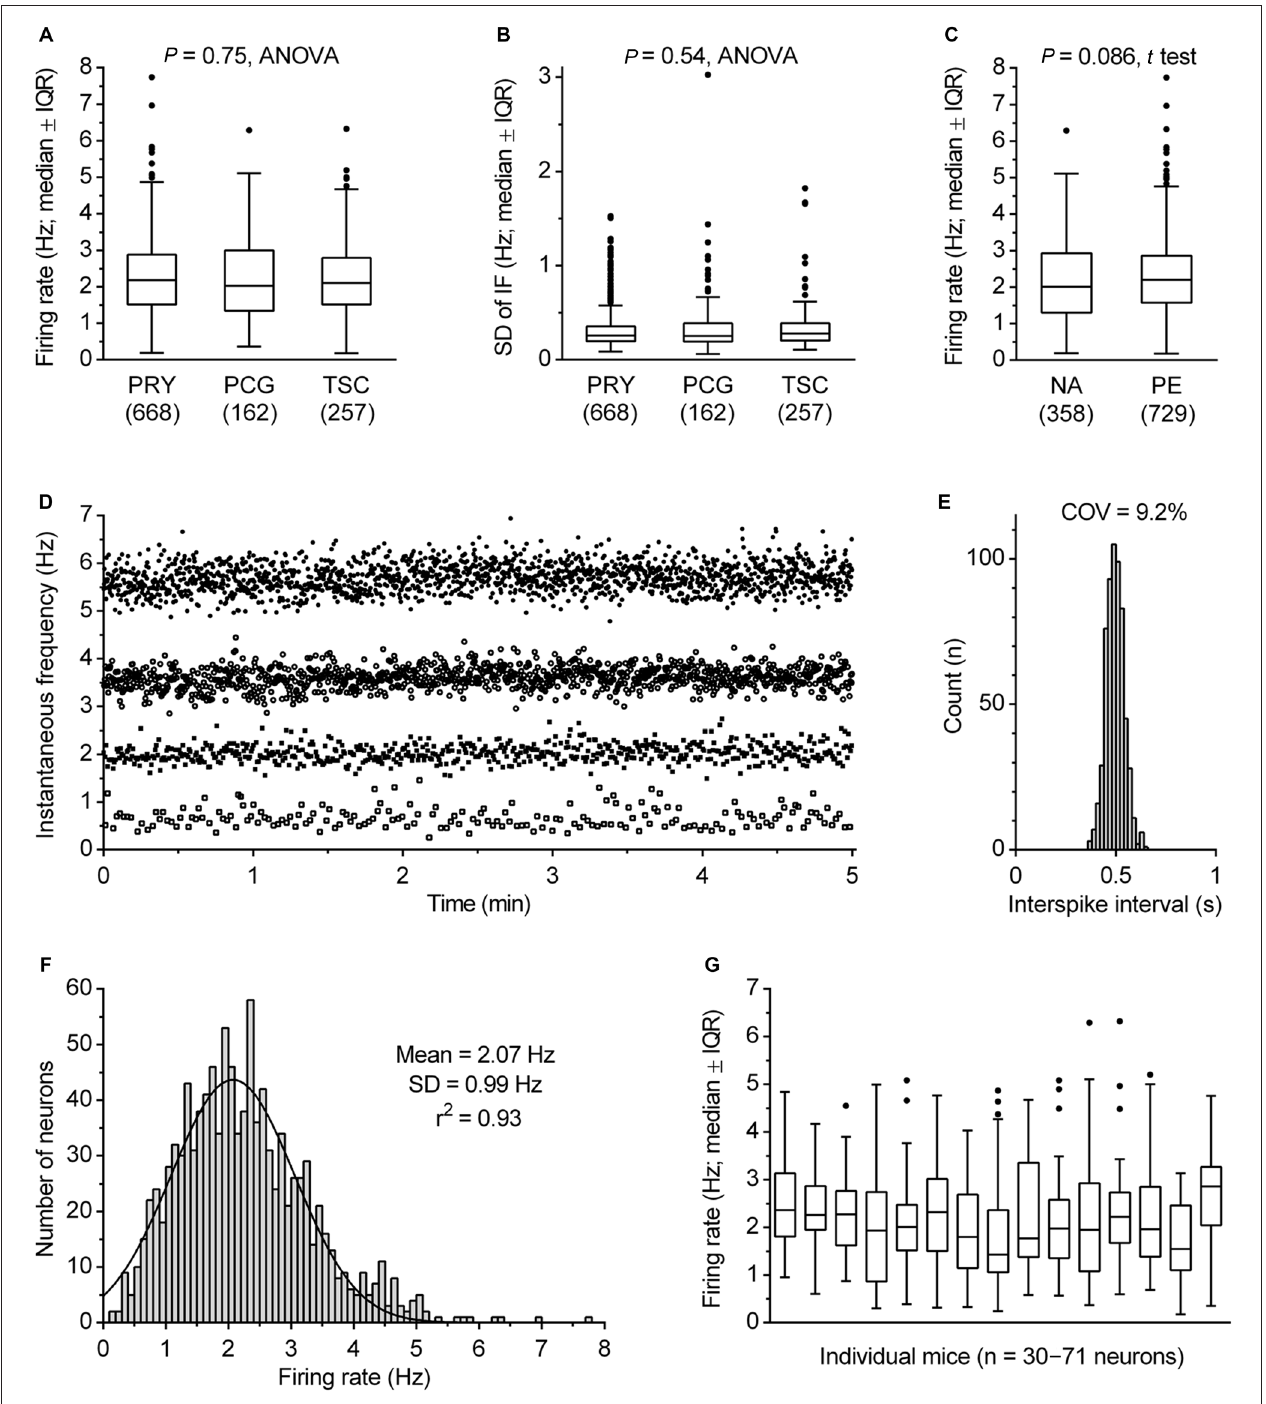
FIGURE 4 | Firing rate of serotonergic neuron population. (A) Comparison of firing rates in transgenic mice lines used in this study. Boxes represent medians and the IQR. Whiskers denote 1.5 IQR. PET1-CRE::ROSA26.YFP (PRY), PET1-CRE::CAG.EGFP (PCG) and TSC stay for PRY, PCG and Tph2-SCFP mouse line, respectively. The number of recorded neurons is indicated in parenthesis. (B) Comparison of SD of instantaneous firing (IF) in three mouse lines. (C) Comparison of firing rates obtained in the presence of 30 µ M NA and 10 µ M PE. Boxes represent medians and the IQR. Whiskers denote 1.5 IQR. (D) Superimposed time-course of four representative recordings covering firing rate range typical for DRN serotonergic neurons. In the examples shown, firing rates were 5.69, 3.59, 2.02 and 0.62 Hz, while SD of instantaneous frequency were 0.29, 0.22, 0.19 and 0.22 Hz, respectively. (E) ISI histogram of 2.02 Hz-firing neuron shown in (C) . COV denotes variation coefficients of ISI. (F) Firing rate histogram of DRN serotonergic neuron population. Curve represents best fit by single Gaussian function. (G) Box plot illustrating variability in firing rate of serotonergic neurons in individual animals. Boxes represent medians and the IQR. Whiskers denote 1.5 IQR.